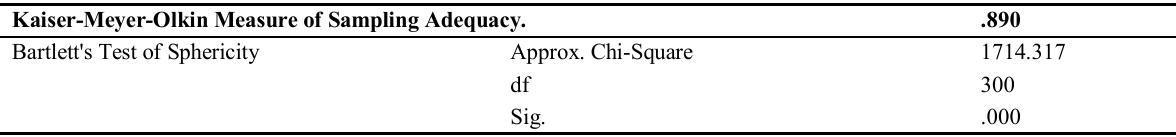
Table 3: KMO and Bartlett’s test of sampling